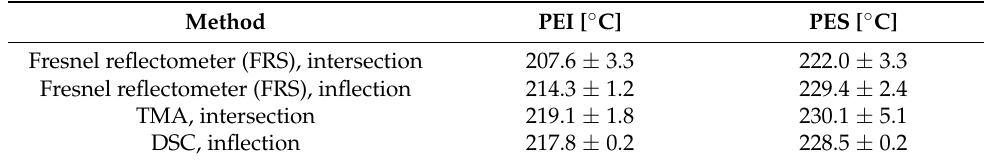
Table 2. Summary of glass transition temperatures. Method Fresnel reflectometer (FRS),